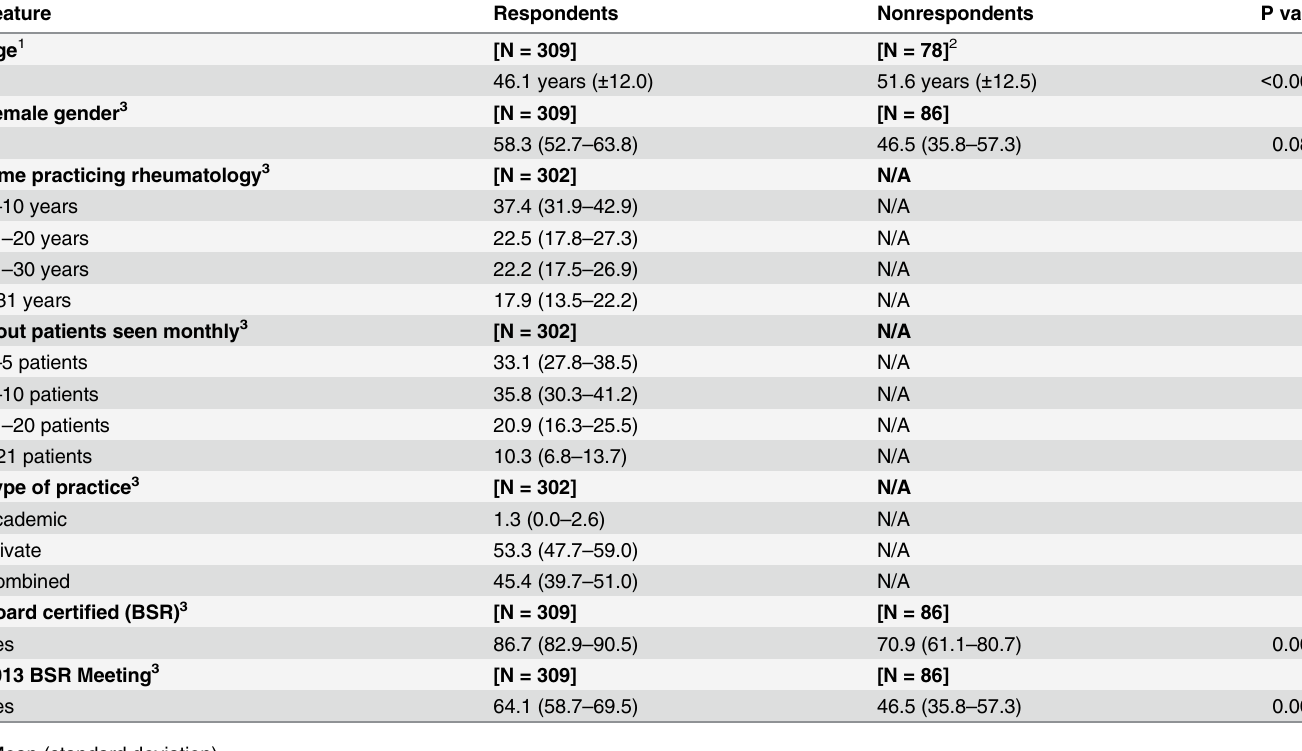
Table 1. Description of the study sample and comparison between respondents and